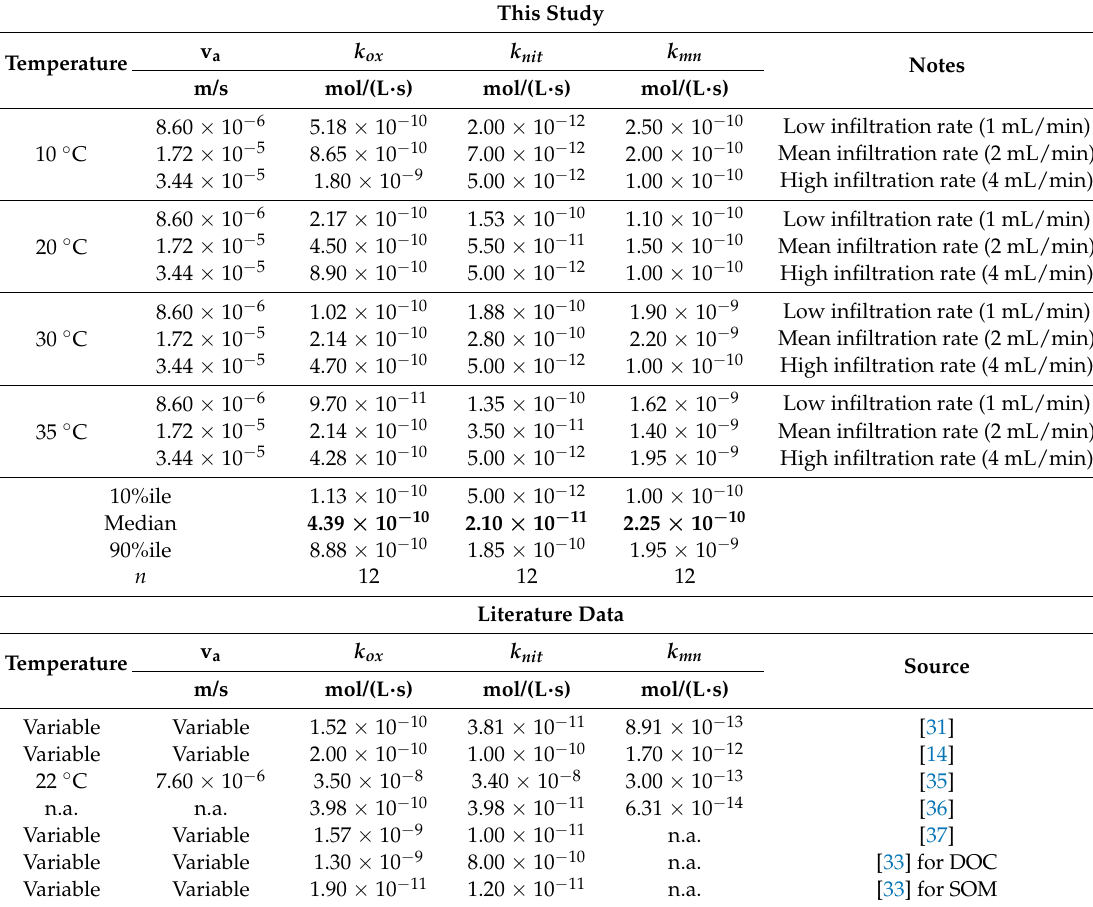
Table 2. The calibrated reduction constants of this study compared to the literature data. This